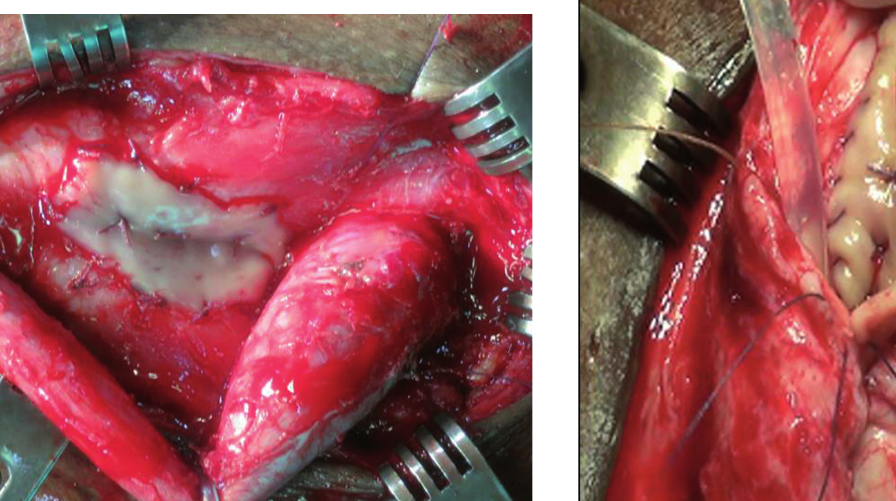
Figure 1 - Dorsal onlay technique.